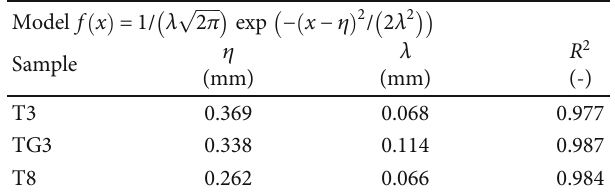
Table 2: Fitting results for aperture distribution using a Gaussian distribution.